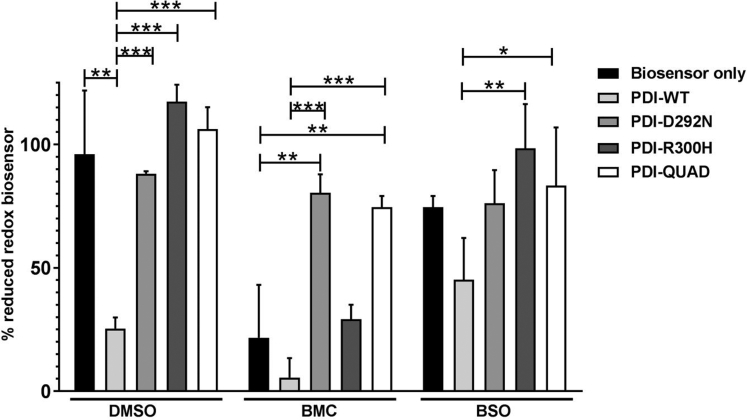
Quantification of the Intracellular Redox Environment in Neuro-2a CellsReduction of biosensor in Neuro-2a cells transiently transfected with the Clover-rxmRuby2 biosensor (RXM) or with different PDI proteins: PDI-WT, PDI-QUAD PDI-D292N, or PDI-R300H. Statistical difference is shown for biosensor alone expressing cells versus cells expressing different PDI proteins (∗∗p < 0.01 and ∗∗∗p < 0.001) and for cells expressing PDI-WT versus the ALS-associated PDI mutants (∗p < 0.05, ∗∗p < 0.01 and ∗∗∗p < 0.001).